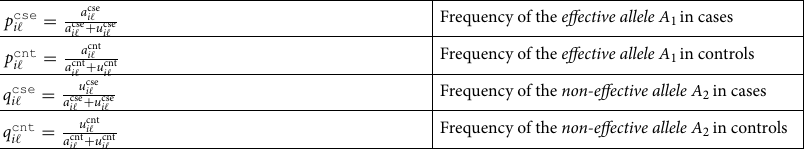
Frequency of the effective allele A 1 in